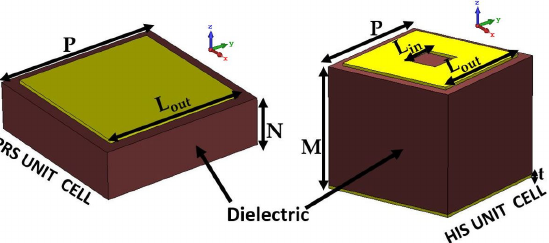
Figure 2. PRS and HIS unit cell structure where L out = 1.50 mm, L in = 0.60 mm and periodicity P = 1.75